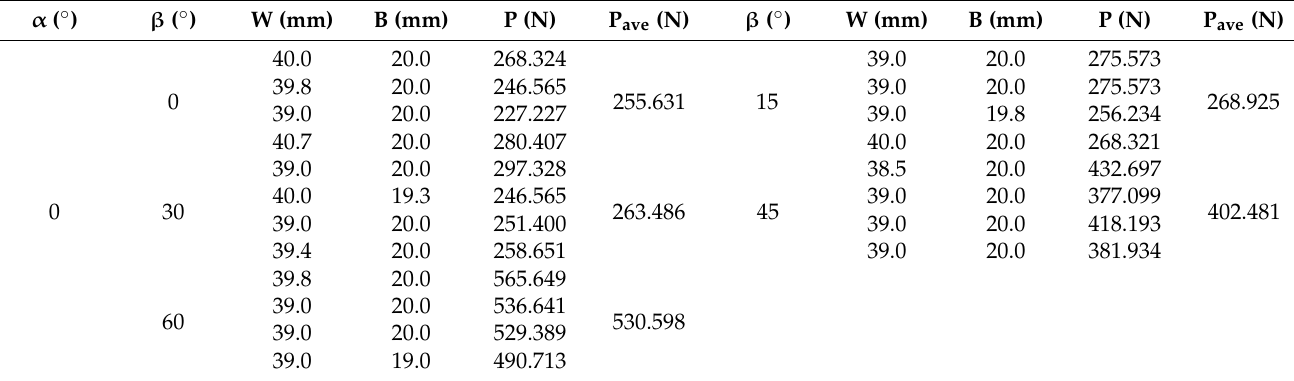
Table A1. The geometric parameters of specimens and fracture loads obtained for the tested sandstone material under different loading